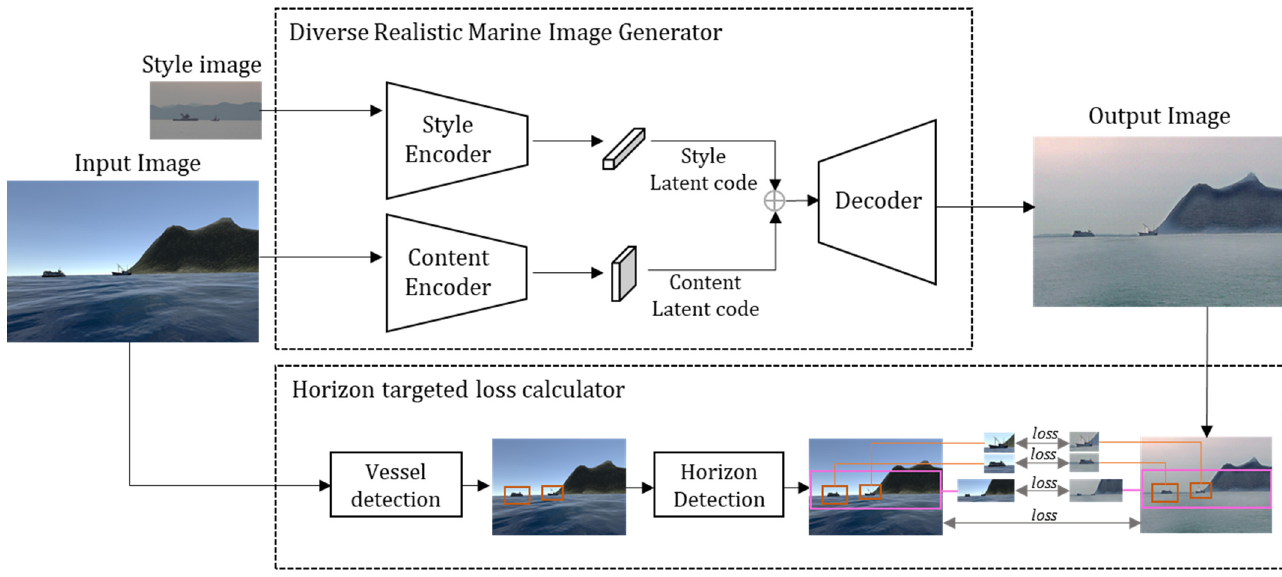
Figure 3. Architecture of the proposed diverse realistic marine image generation framework.